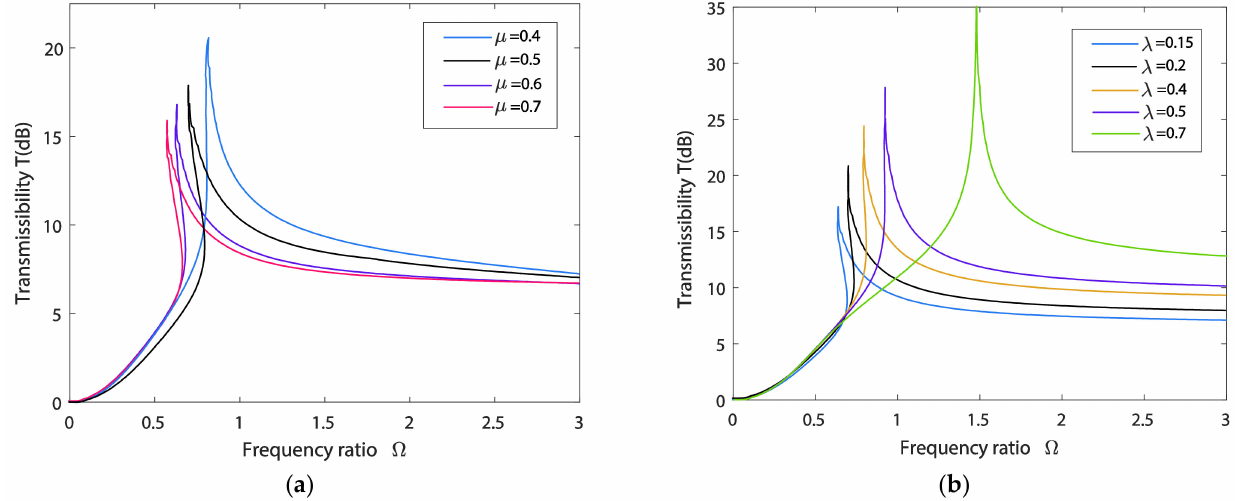
Figure 17. The absolute displacement transmissibility of the QZS-IE seat suspension system with different parameters of the inerter element: ( a ) Variation of µ at ζ = 0.05, λ = 0.2, u 0 = 1.0, ε = 2; ( b ) variation of λ at ζ = 0.05, µ = 0.4, u 0 = 1.0, ε =